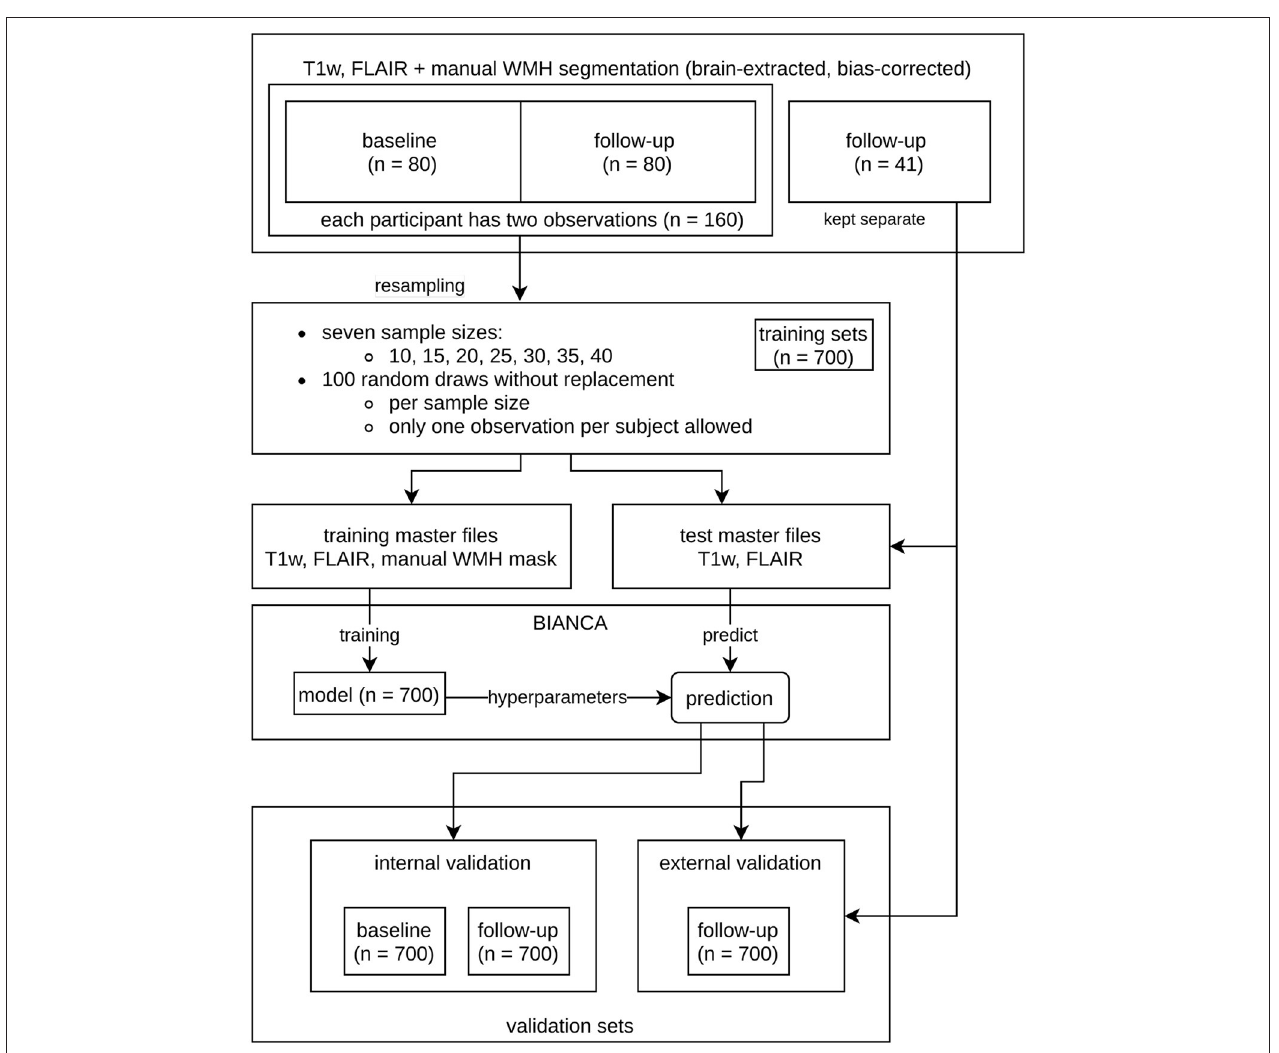
FIGURE 2 | Overview of the resampling procedure for training the Brain Intensity AbNormality Classification Algorithm (BIANCA) models with varying sample sizes and evaluation of white matter hyperintensities (WMH) segmentation performance. The initial dataset consisted of the same 80 participants at baseline (BL) and follow-up (FU), as well as a separate external validation set with 41 participants. To prevent data leakage, all observations of a participant used in the training procedure were not allowed into the corresponding validation set. The resampling parameters are shown in the middle (7 sample sizes ranging from 10 to 40 with increments of 5; per sample size 100 random draws without replacement, only one observation per participant allowed). The corresponding validation sets (internal and external) are shown at the